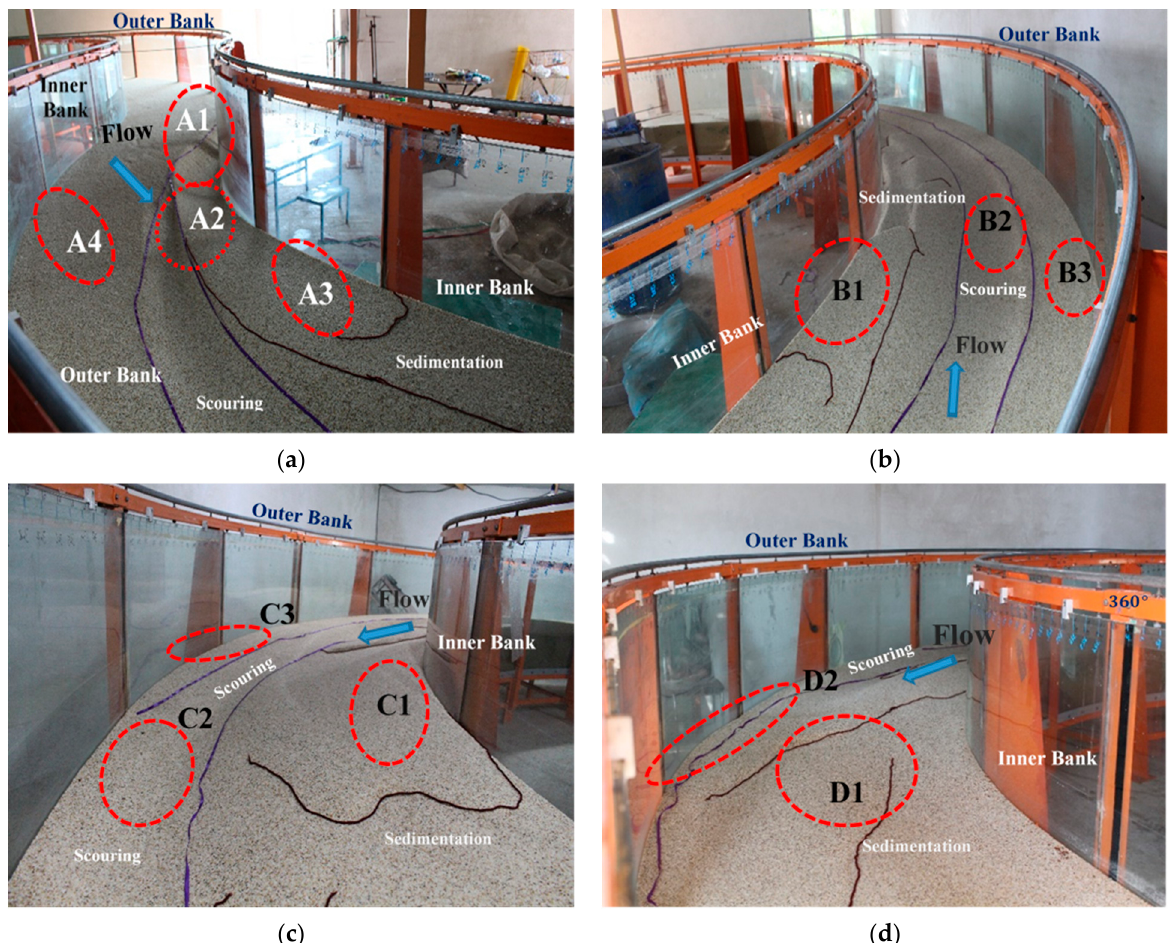
Figure 5. Instances of bed topography variations in the laboratory for U/Uc = 0.98 between ( a ) 165 and 235, ( b ) 217 and 280, ( c ) 250 and 310, and ( d ) 300 and 360 degrees.